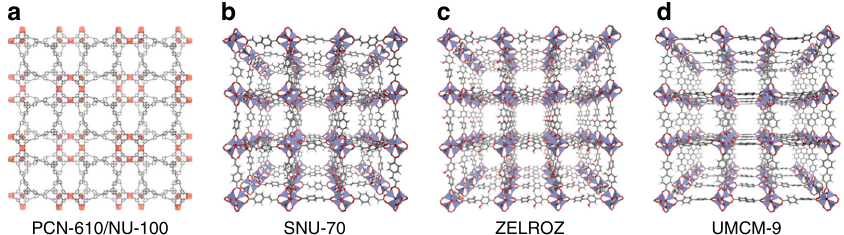
Fig. 2 Crystal structures of MOFs whose hydrogen uptake was assessed experimentally following their identi fi cation by computational screening. a PCN- 610/NU-100, b SNU-70, c ZELROZ, and d UMCM-9 (C: gray, H: white, O: red, Cu: orange and Zn: blue) Table 3 Measured and calculated crystallographic properties of high-capacity MOFs examined in this study MOF